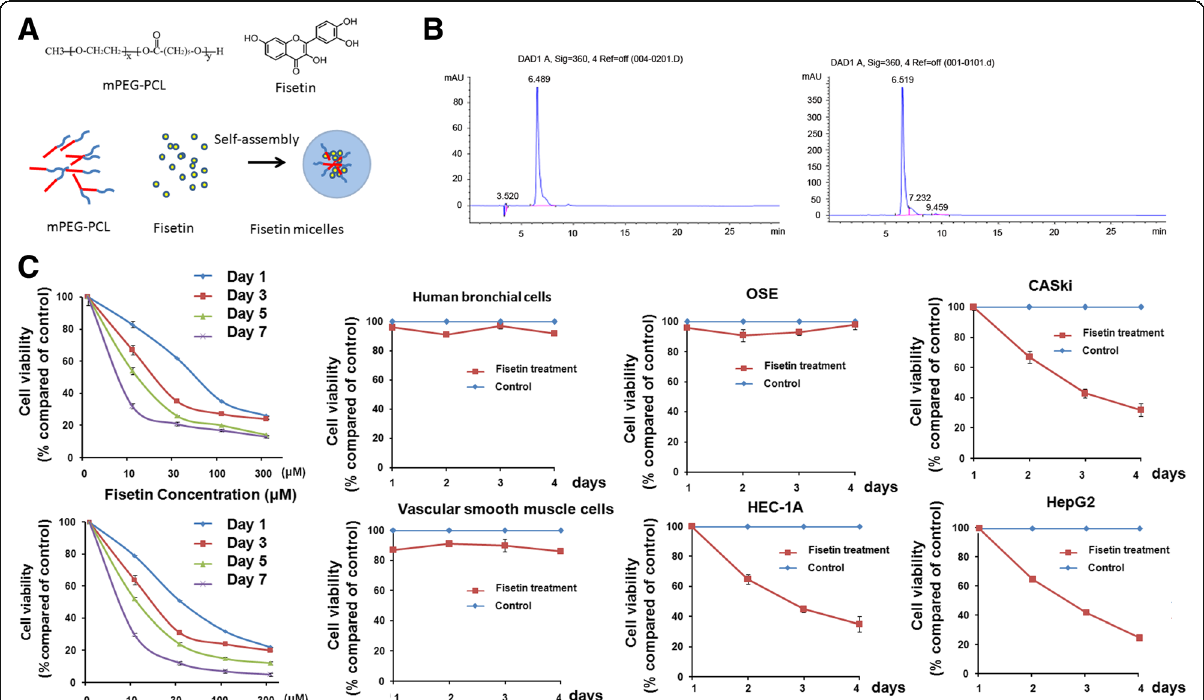
Fig. 1 Fisetin and fisetin micelles inhibit tumor cell proliferation. a Chemical structure of fisetin, Chemical structure of mPEG-PCL copolymer and preparation scheme of fisetin micelles by the self-assembly method. b High performance liquid chromatography of fisetin and fisetin micelles. c Various cell lines were treated with30uM fisetin/fisetin micelles for different time periods (1 day to 4 days). Cell viability was detected by MTT assay. Fisetin does not have any inhibit effect on the survival of normal cell lines. Fisetin and fisetin micelles decreae cell viabilities of tumor derived cell lines such as HEC-1A, CASKi, HepG2. Dose-time-effect curves for fisetin and fisetin micelles on the SKOV3 cell line for 1, 3, 5 and 7 days and 10 μ M,30 μ M, 100 μ M, 300 μ M, Error bars represent standard error of the mean (SEM) ( n = 3) * P < 0.05, vs. day 1 group; △ p < 0.05, vs. control